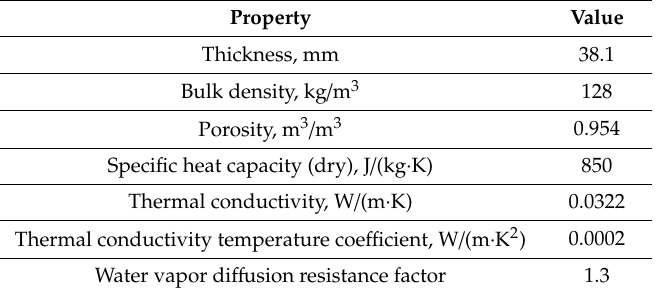
Table A8. MW property data.